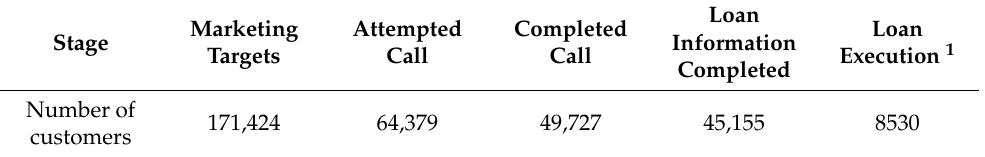
Table 2. Number of customers by outbound telemarketing